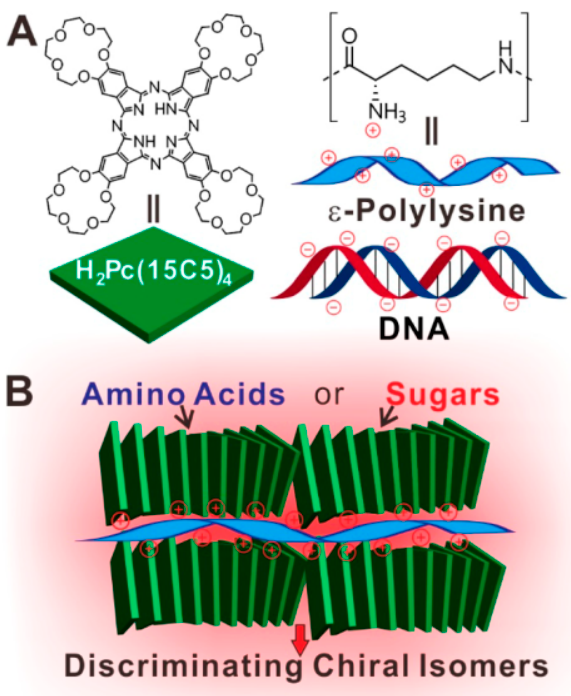
Figure 1. ( A ) Chemical structure of the tetrasubstituted 15-crown-5 ethers phthalocyanine derivative and the two biomolecules. ( B ) Schematic representation of the formation of Pc/poly( L -lysine) assemblies. Reprinted with permission from ref. [52]. Copyright 2017 American Chemical Society.